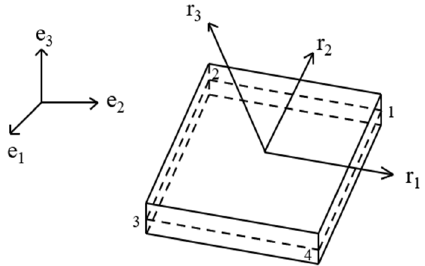
Figure 6. Four-node shell element.